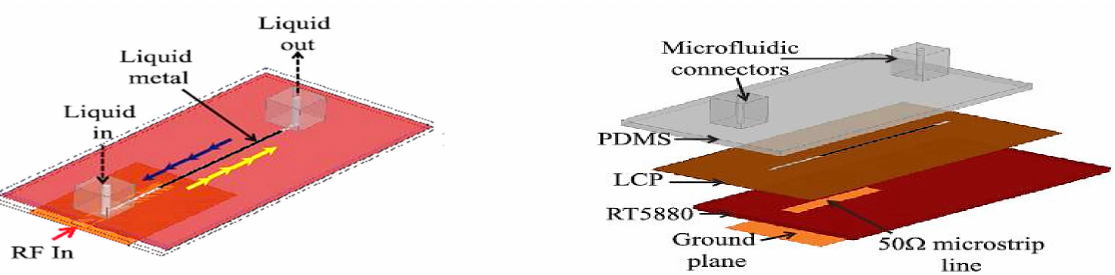
Figure 31. Substrate stack-up of the liquid-metal monopole antenna [38]. Next, a fluidically switched Vivaldi antenna using ionized water was proposed in [58], whose operation can be tuned between the 3.2 and 4.5 GHz band. A microstrip feed line with an open circuit stub is fabricated on the top layer of the substrate, as illustrated in Figure 32. The feed line couples the signal to the slot line on the bottom layer. The conductive fluid switch enclosure contains deionized water dissolved using 2 mol of potassium chloride (KCI) solution. Operation in the higher frequency band of 4.5 GHz is achieved by pumping conductive fluid into the switch to shorten the current path. On the other hand, draining out the fluid enables operation at 3.2 GHz with an efficiency of 87%. The measured gain for this antenna is 11 and 10.9 dBi at 3.2 and 4.5 GHz, respectively.